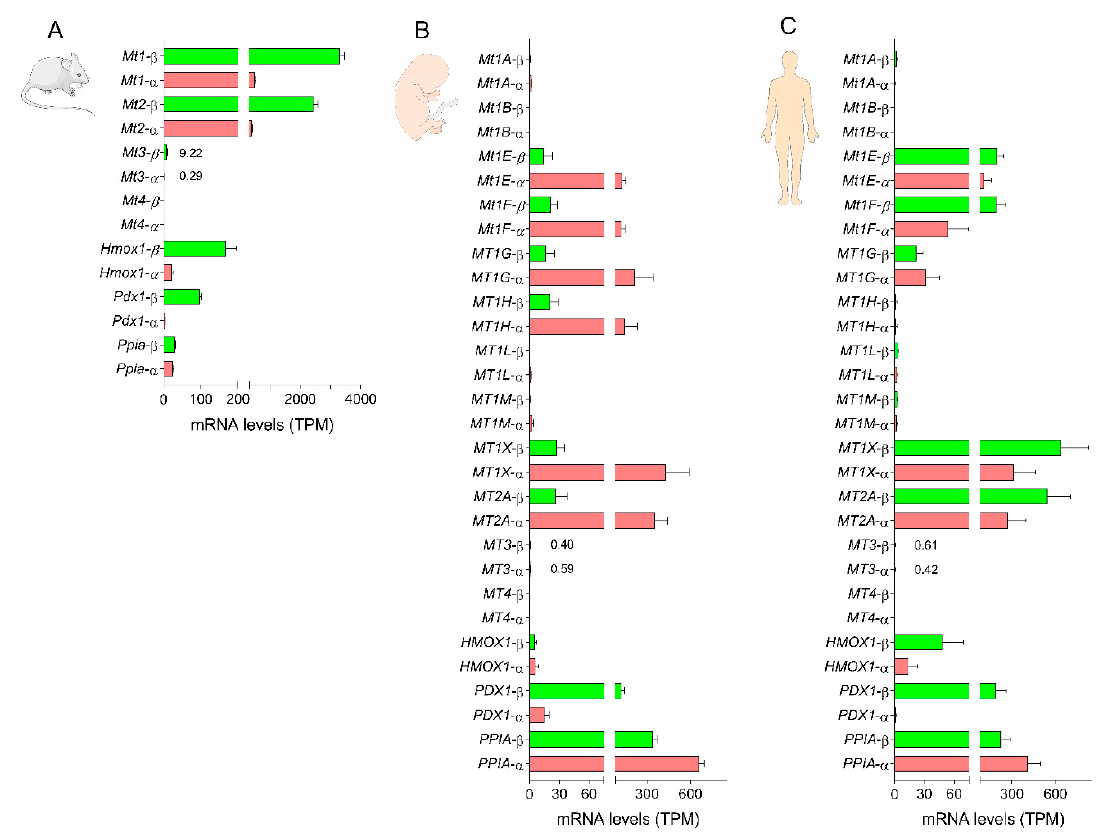
Figure 2. Pattern of metallothionein gene expression in pancreatic beta and alpha cells. ( A ) Changes in the mRNA levels of Mt1-4 , Hmox1 , Pdx1 and Ppia in purified mouse beta and alpha cell preparations. Data are the means of the average number of transcripts per million (TPM) ± SEM for 5 (beta) and 3 (alpha) preparations. RNA sequencing data were obtained from the Gene Expression Omnibus database under the accession number GSE80673 [77]. ( B ) Changes in the mRNA levels of MT1A , MT1B , MT1E , MT1F , MT1G , MT1M , MT1X , MT2A , MT3 , MT4 , HMOX1 , PDX1 and PPIA in purified human fetal beta and alpha cell preparations. ( C ) Changes in the mRNA levels of MT1A , MT1B , MT1E , MT1F , MT1G , MT1M , MT1X , MT2A , MT3 , MT4 , HMOX1 , PDX1 and PPIA in purified human adult beta and alpha cell preparations. Data are the means of the average number of TPM ± SEM for 5 (fetal alpha), 6 (adult alpha and fetal beta) and 7 (adult beta) preparations. RNA sequencing data were obtained from the Gene Expression Omnibus database under the accession number GSE67543 [78] .